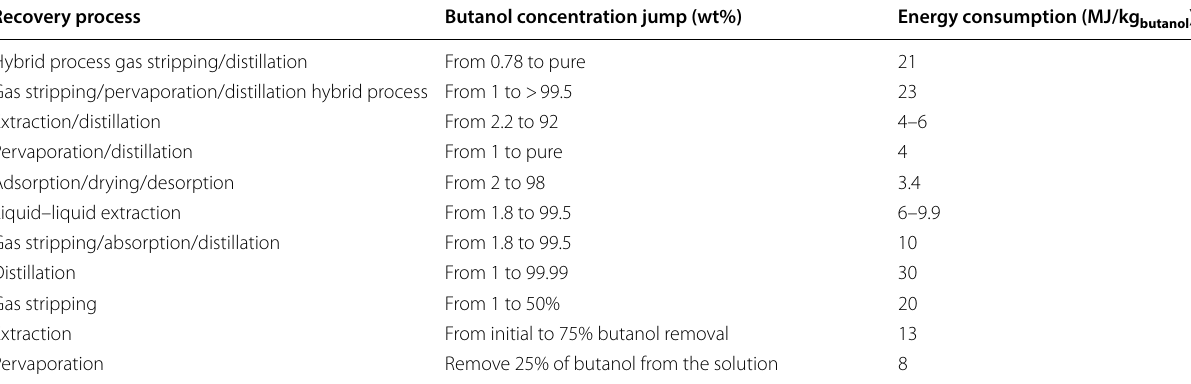
Table 3 Energy requirement to separate acetone–butanol–ethanol from fermentation broth using different recovery techniques [Refs. (Abdehagh et al. 2013; Huang et al. 2014; Raganati et al.